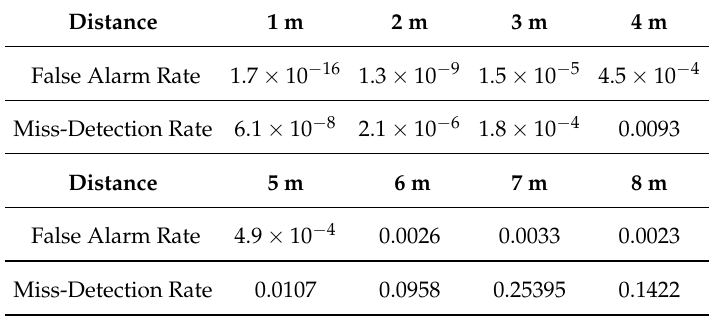
Table 9. Performance analysis in a heavy clutter environment when P Fa = 10 − 4 , P Md = 10 − 3 , α = 0.7.